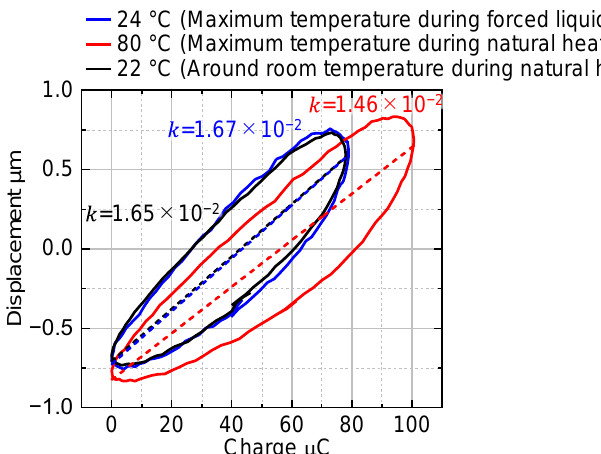
Figure 4. Measured charge displacement curves with natural heat dissipation and liquid cooling when a bias voltage of 50 V and sinusoidal voltage of 24 V at a frequency of 10 kHz were applied to the PESA. The dashed lines are linear approximations.